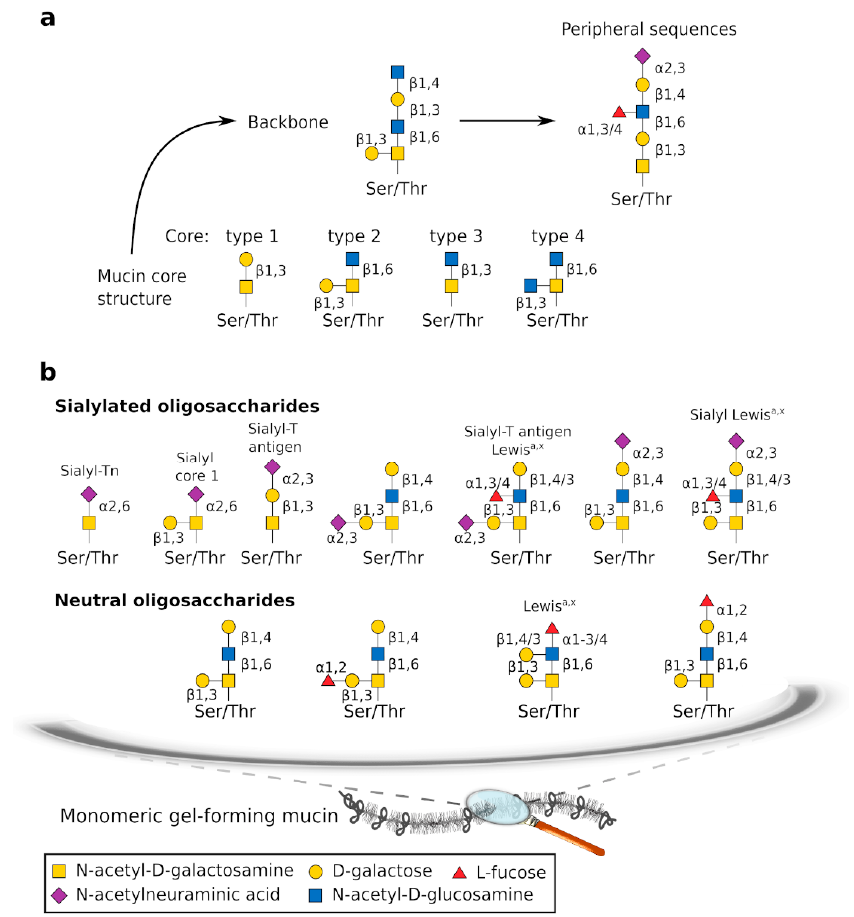
Figure 2. Oligosaccharide chains of human GFMs. ( a ) Theoretical O -glycosylation. The backbone is made of repeated units, which are not represented. Among the eight known types of mucin core structure, cores 1–4 are the most common. ( b ) Examples of the main GFM glycans of cervicovaginal mucus (CVM), which are mainly sialylated and fucosylated. More neutral oligosaccharides than sialylated oligosaccharides are detected at midcycle than at pre- or post-ovulation. The sugar code letter and O -glycan structure are from Kaltner et al. [17].